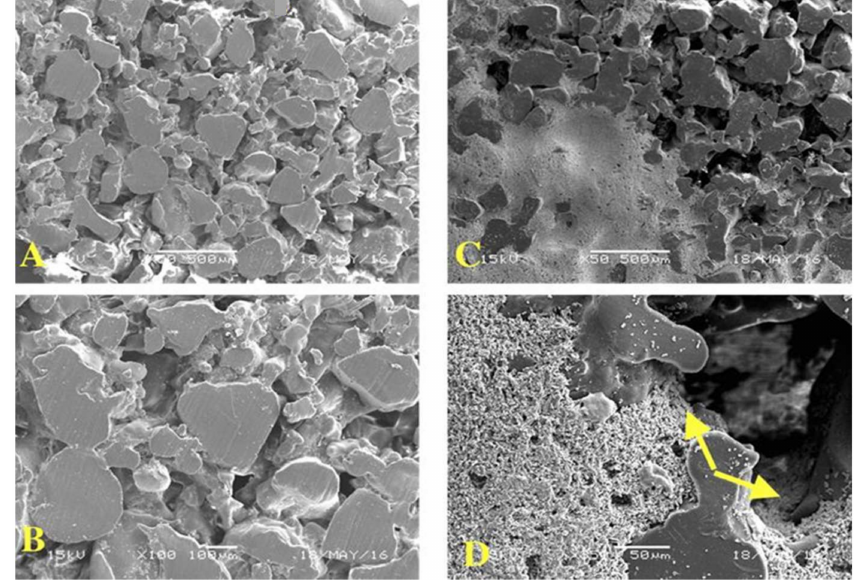
Figure 8. Microradiograph for scanning electron microscopy of porous polyethylene. ( A , B ) show the cut section of non-coated porous polyethylene; the variation in pore size is noted to vary within the range of 50–400 µ m. ( A , B ) scale bars = 500 and 100 µ m. ( C , D ) show the coated porous